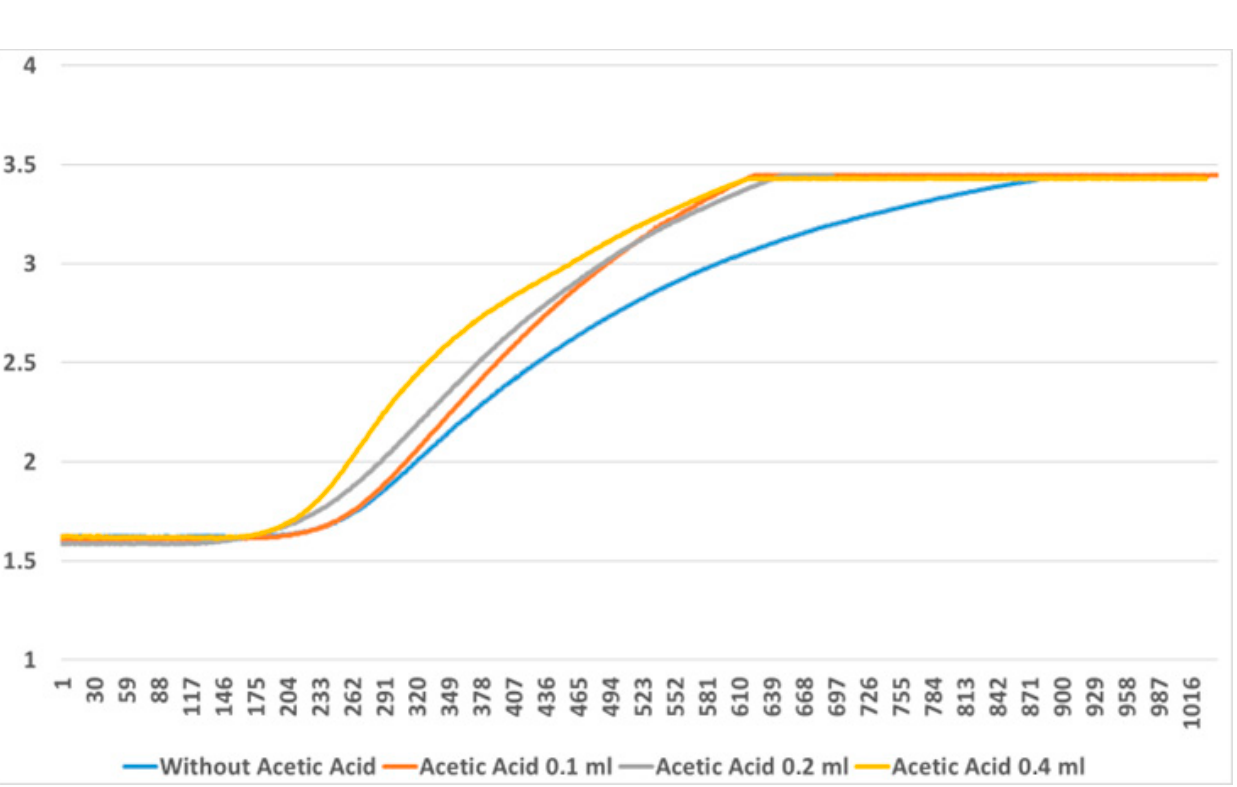
Figure 6. Details of upward slopes of wine with and without acetic acid ( top ); details of downward slopes of wine with and without acetic acid ( bottom ). The sampling time is measured in tenths of a seconds. The aim of our work, in addition to designing and manufacturing the device and therefore carrying out the experiments with the four samples, is to create a database of red wine sample features, including upward slopes and downward slopes. With the four different concentrations (wine, wine +1% acetic acid, wine +2% acetic acid, and wine +4% acetic acid), 84 tests were carried out for the database and the slopes were calculated using MatLab. We programmed MatLab code to calculate and compare the different slopes. In Figure 7, the result of the database with the mean values of the upward slopes can be seen. In addition, the minimum and maximum values, the median, and the first and third quar- tiles have been calculated. We can verify that the quantity of acetic acid in the wine deter- mines the slope by comparing 0.1 and 0.2 mL of acetic acid, where the values are similar; however, if we pay attention to the 0.4 mL values, there is a larger difference.